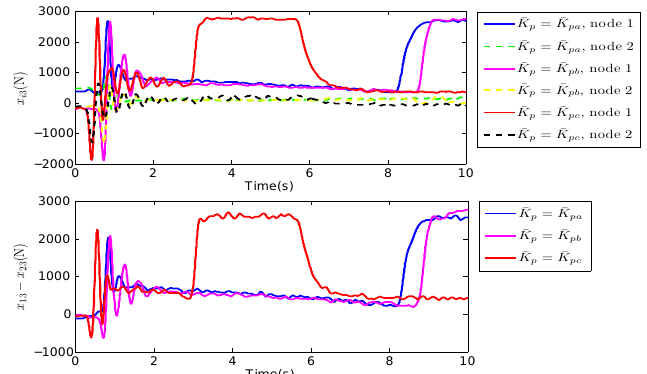
Figure 14. The compared pressure response results of the three state-feedback matrices using pole placement in the